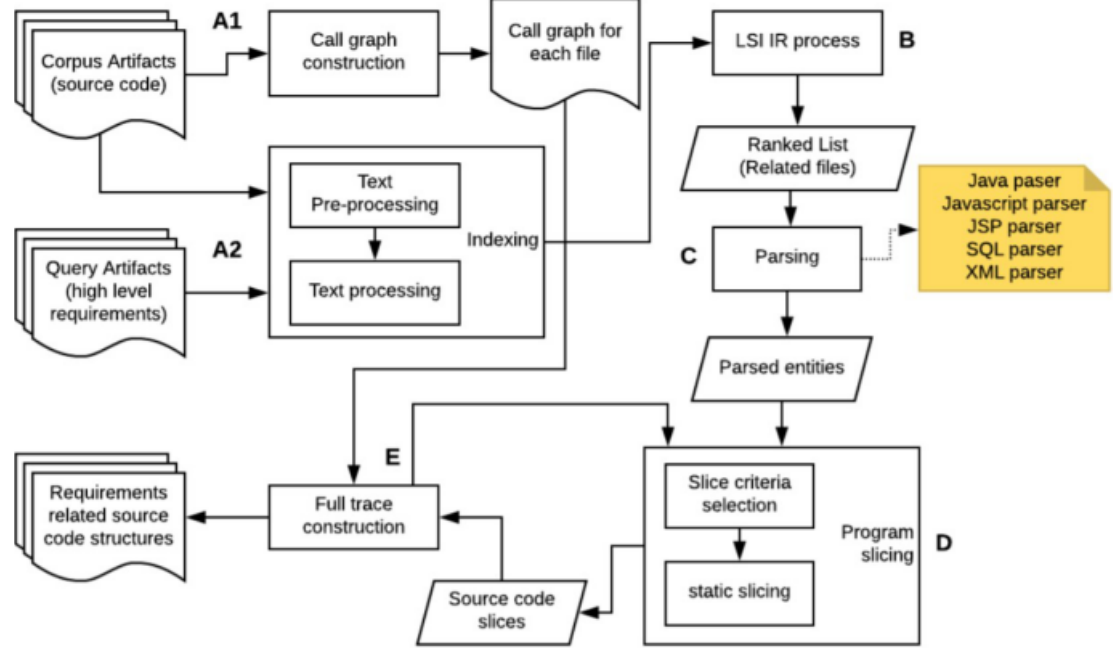
Figure 2: Flow diagram of proposed Fine-Grained traceability